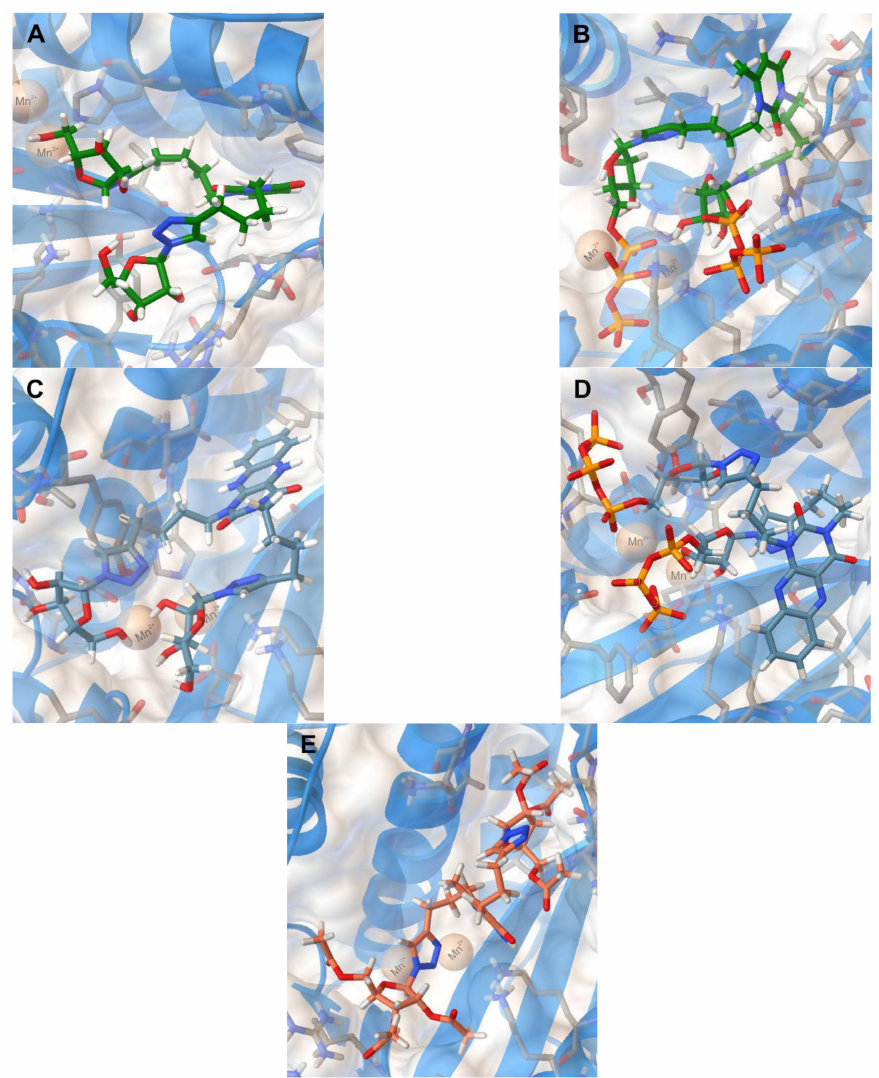
Figure 3. Molecular docking simulations of the optimized docking model of compounds 2i ( A ), 2i - TP ( B ), 5i ( C ), 5i-TP ( D ), 11c ( E ) in the PA-Nter (PDB code 5I13) active site obtained in the lowest-energy